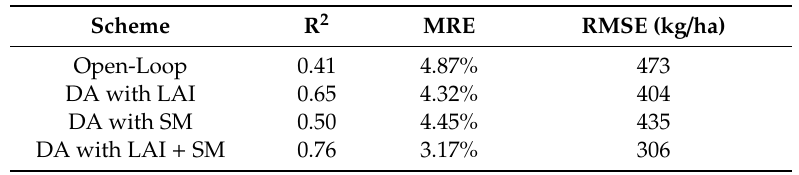
Table 2. The performance of the different DA strategies for WOFOST simulating of winter wheat yield at field scale (N = 22), in Hengshui in 2017.